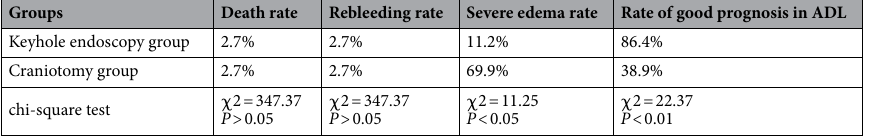
Table 2. Comparison of two groups of patients in postoperative